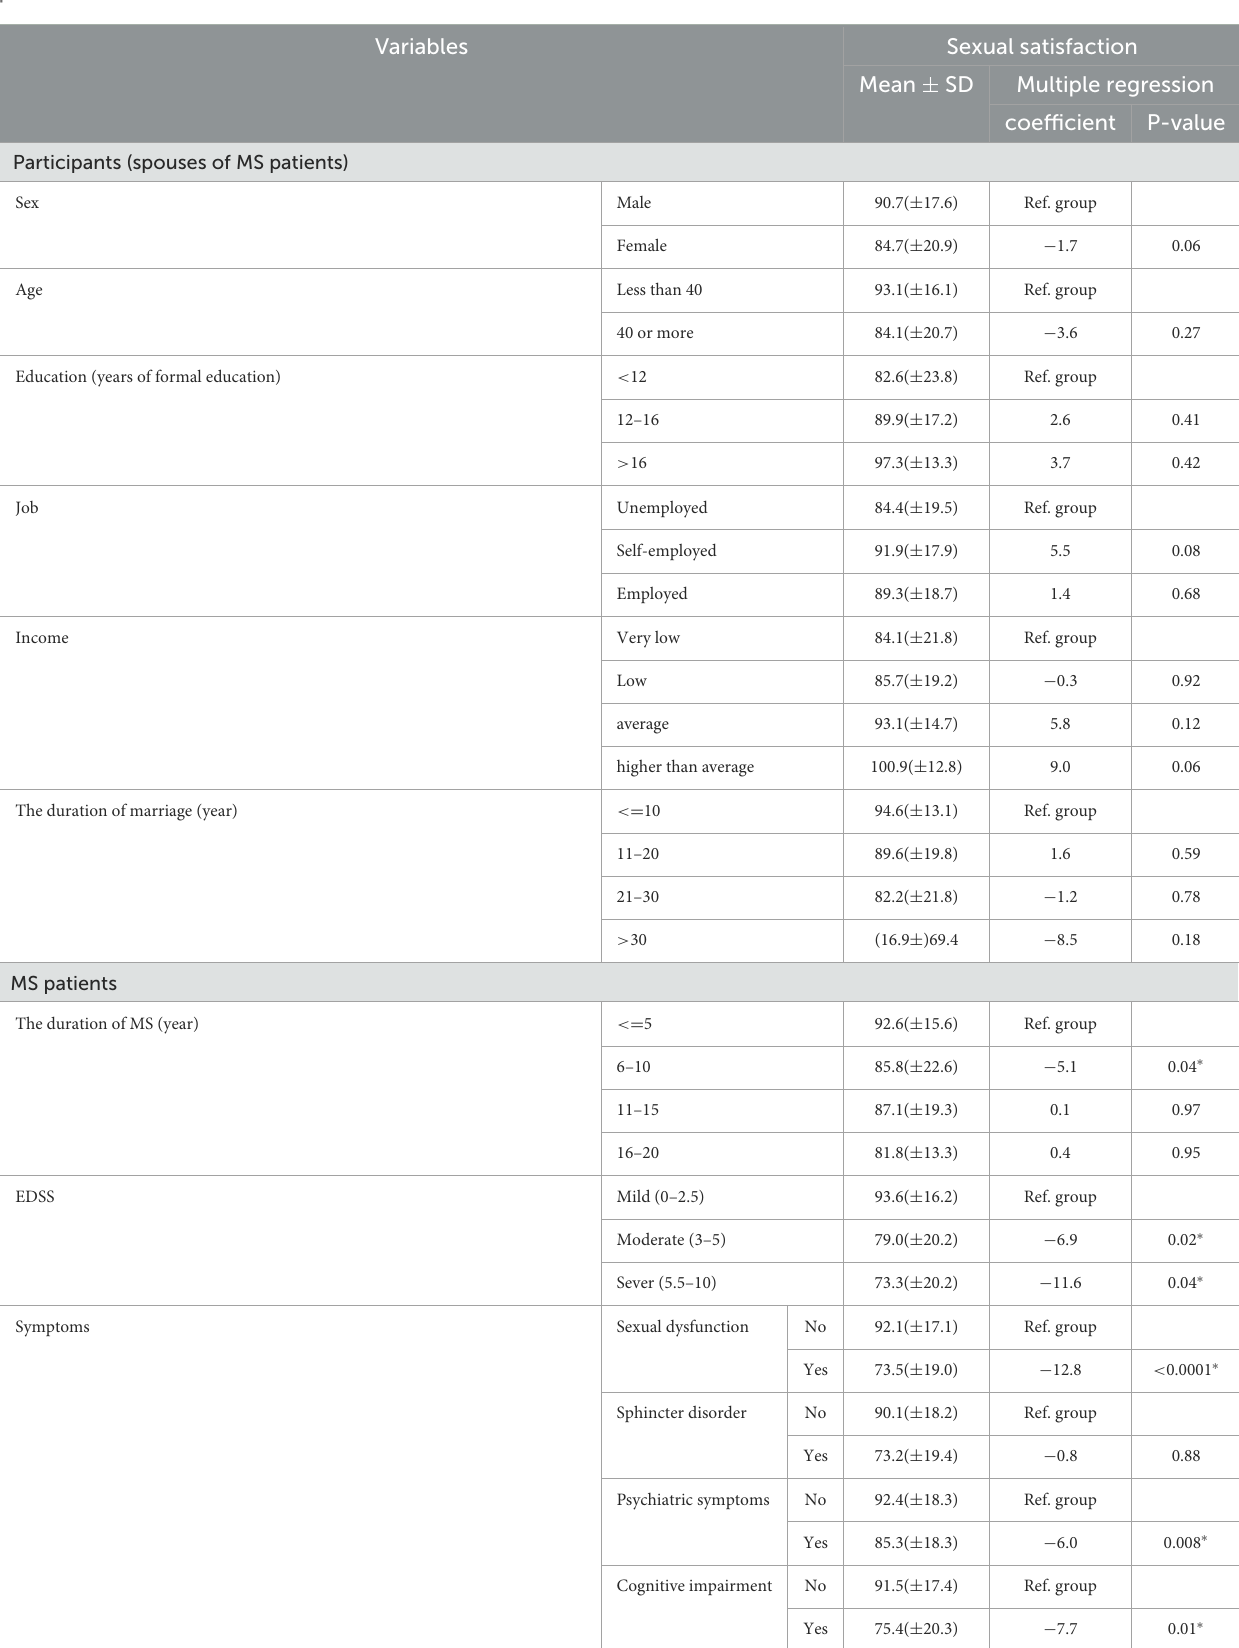
TABLE 3 Results of linear regression models and SS of spouses were linked (as dependent variables) to demographic variables, and the clinical presentations of the MS cases.